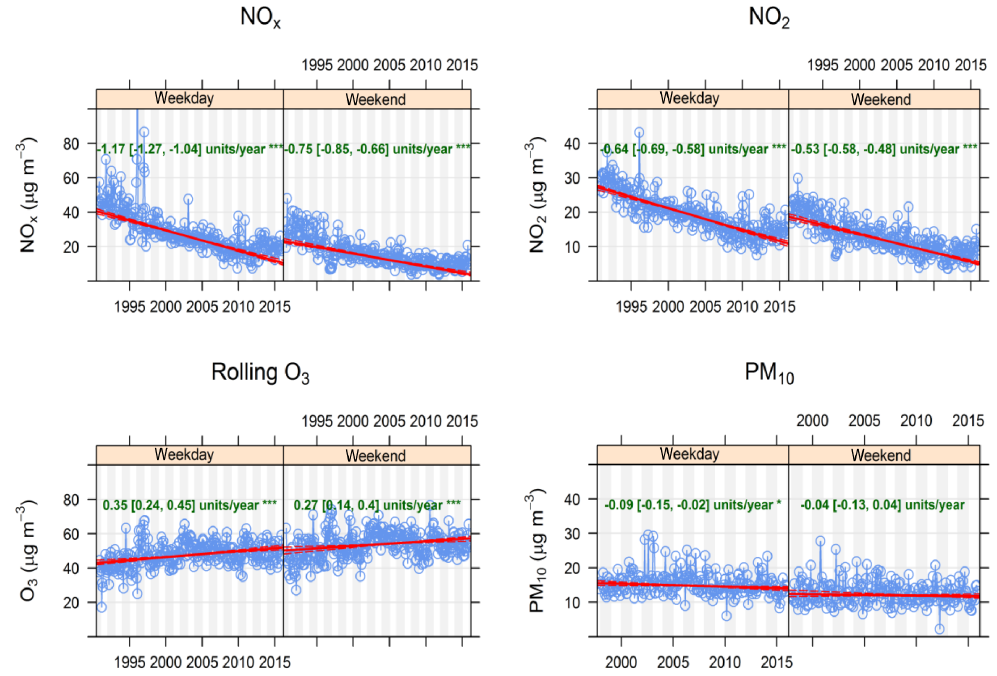
Figure 6. Stockholm: the trends for NO x , NO 2 , O 3 , and PM 10 , divided into weekdays and weekends.